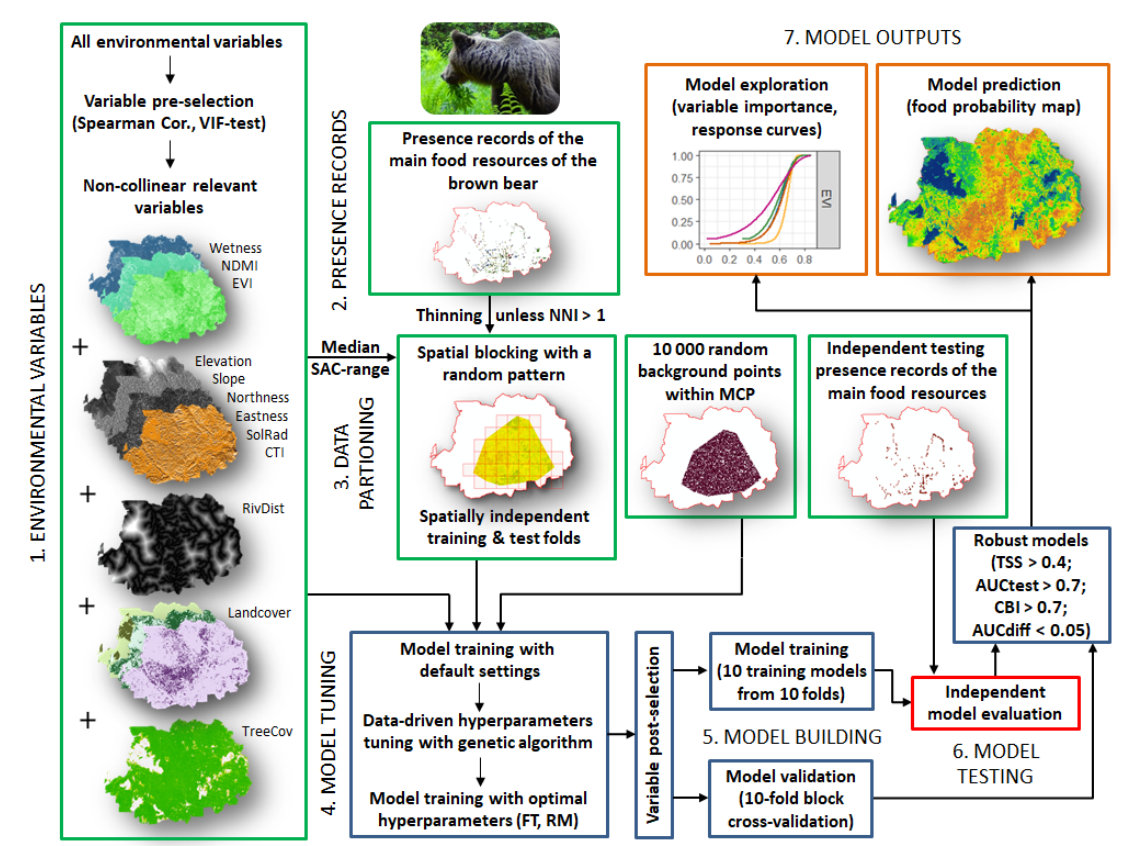
Figure 2. Modelling workflow with seven main steps for 14 brown bear food-probability models with the MaxEnt algorithm for the territory of the Central Forest State Nature Reserve (West-European Russia) in 2008–2020.